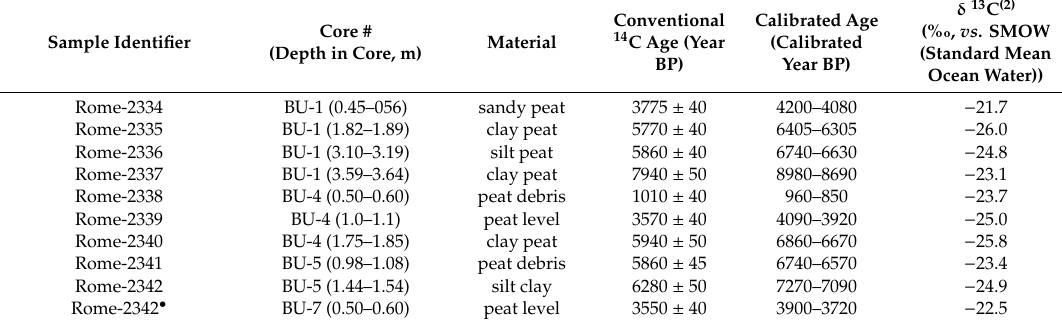
Table 2. Radiocarbon datings (LB samples